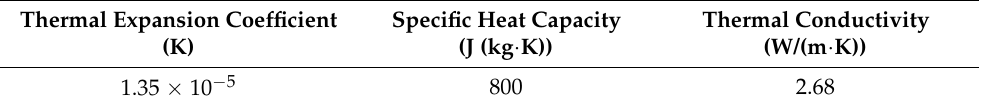
Table 2. Thermal parameters of the granite thermodynamic model [based on [54]].